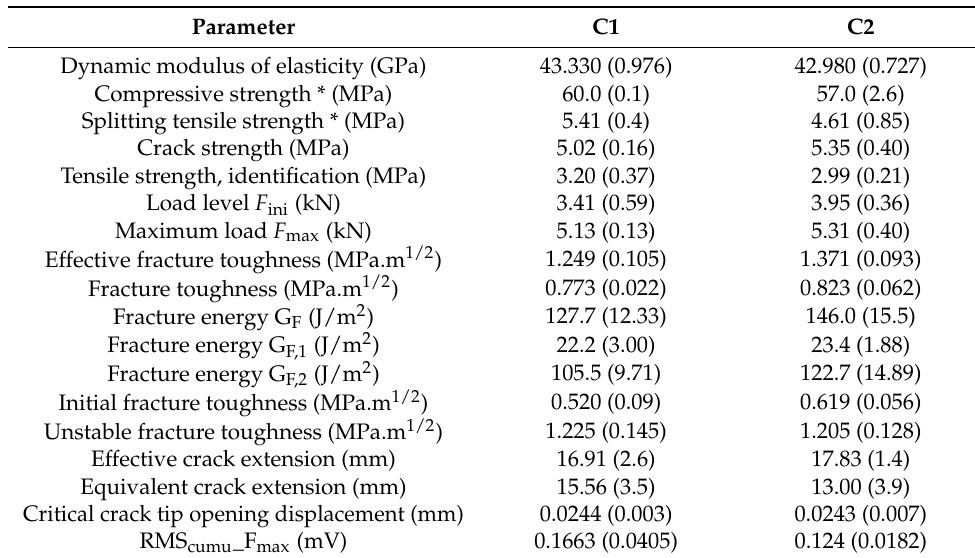
Table 3. Mechanical, fracture, and AE characteristics of non-frost attacked concretes C1 and C2: average value (standard